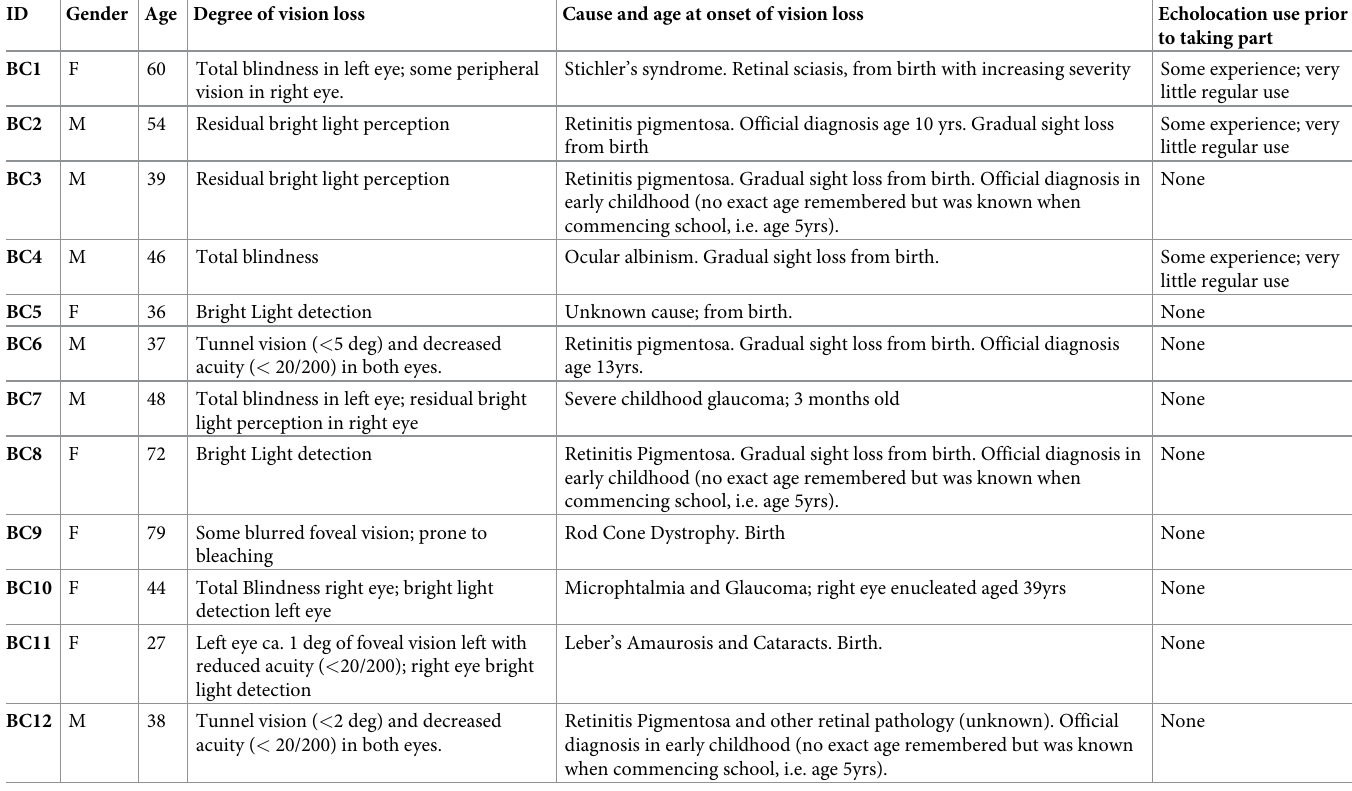
Table 1. Details of participants who were blind. Total blindness in left eye; some peripheral vision in right eye.